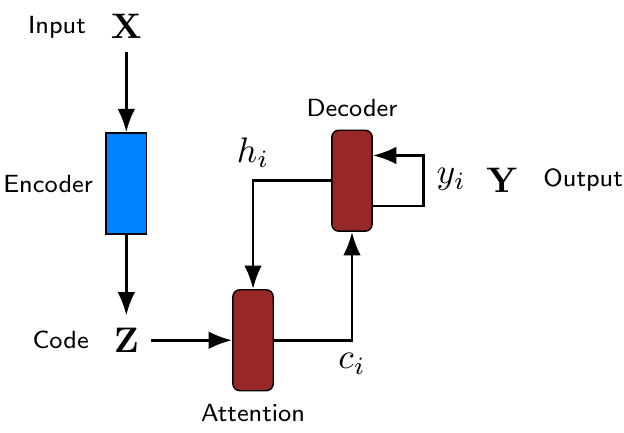
Figure 5. An encoder–decoder architecture with attention mechanism. X : Input